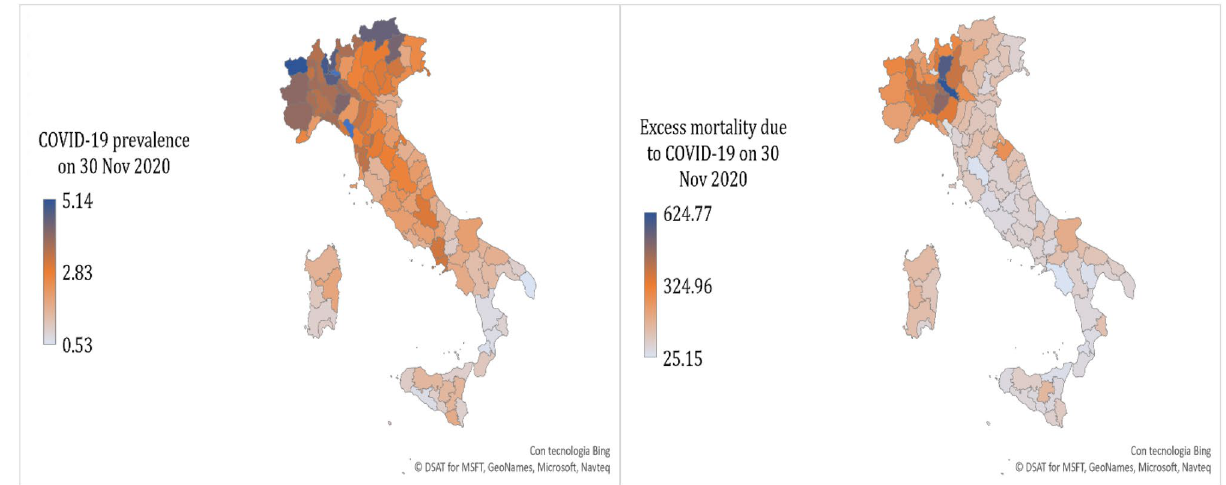
Figure 2. COVID-19 prevalence and related mortality in 107 Italian provinces (on 30 November 2020). Source: own elaborations on data from Italian Ministry of Health 109 , I.Stat 36 , and Istat 108 . The map was generated using Microsoft Excel software